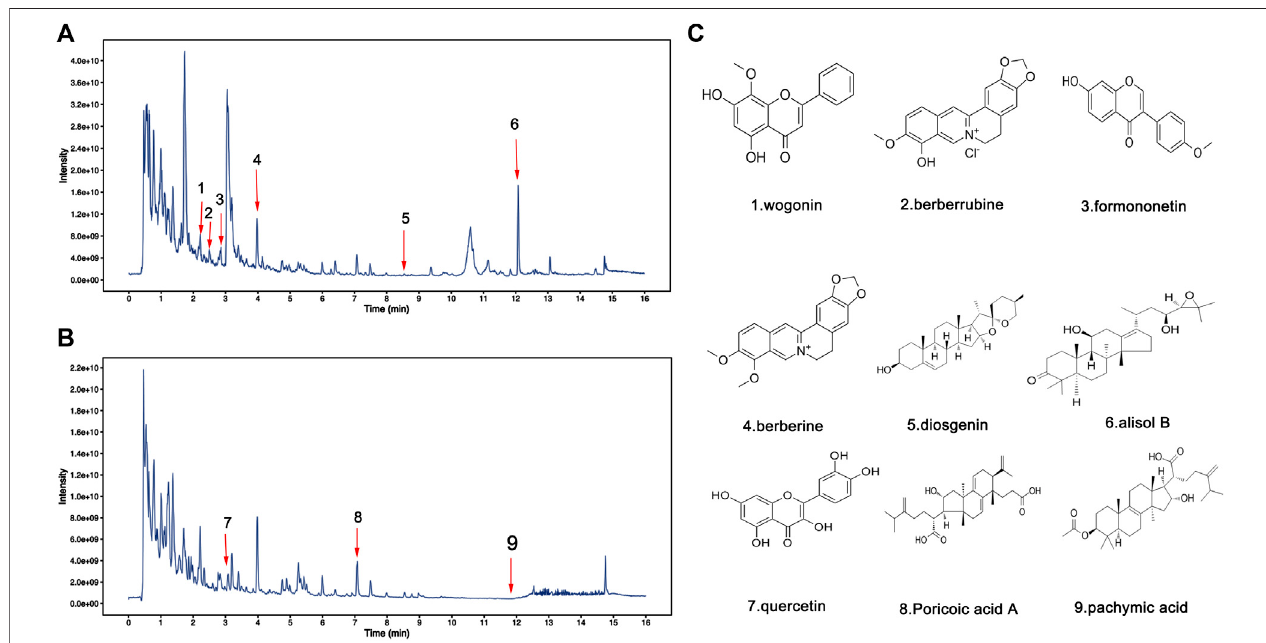
FIGURE3| Identi fi cationofchemicalcomponentsinwaterextractsolutionsofFSGDbyultra-highperformanceliquidchromatographytandemmassspectrometry (UHPLC – MS/MS).Totalionchromatographyinpositive (A) andnegative (B) ionmodesforFSGDsamplesasshown.Thenumbercorrespondstothecompoundonthe left. (C) Molecular structure of